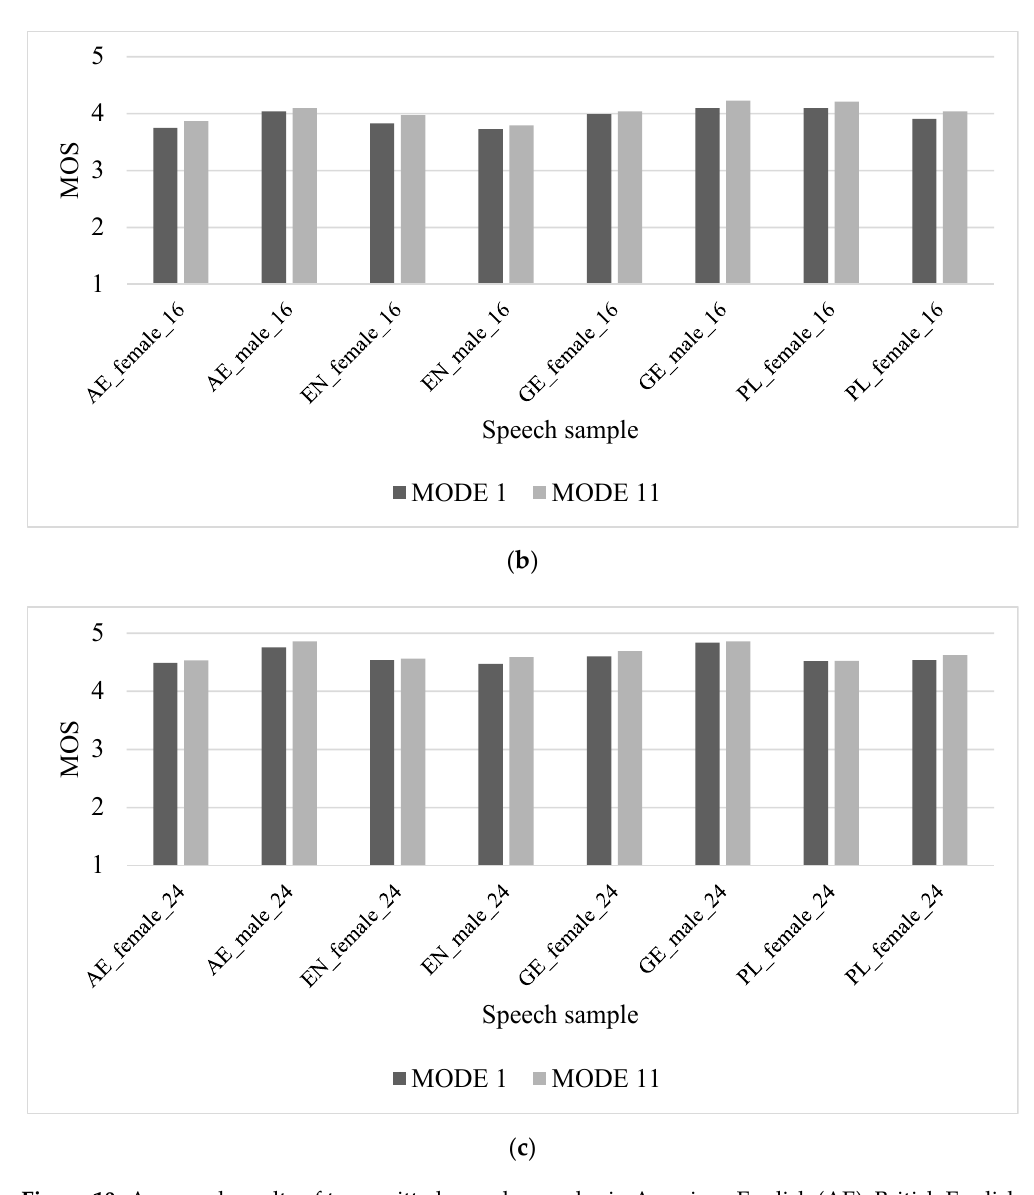
Figure 10. Averaged results of transmitted speech samples in American English (AE), British English (EN), German (GE), and Polish (PL), coded at different bitrates: ( a ) Bitrate of 8 kbps; ( b ) Bitrate of 16 kbps; ( c ) Bitrate of 24 kbps.